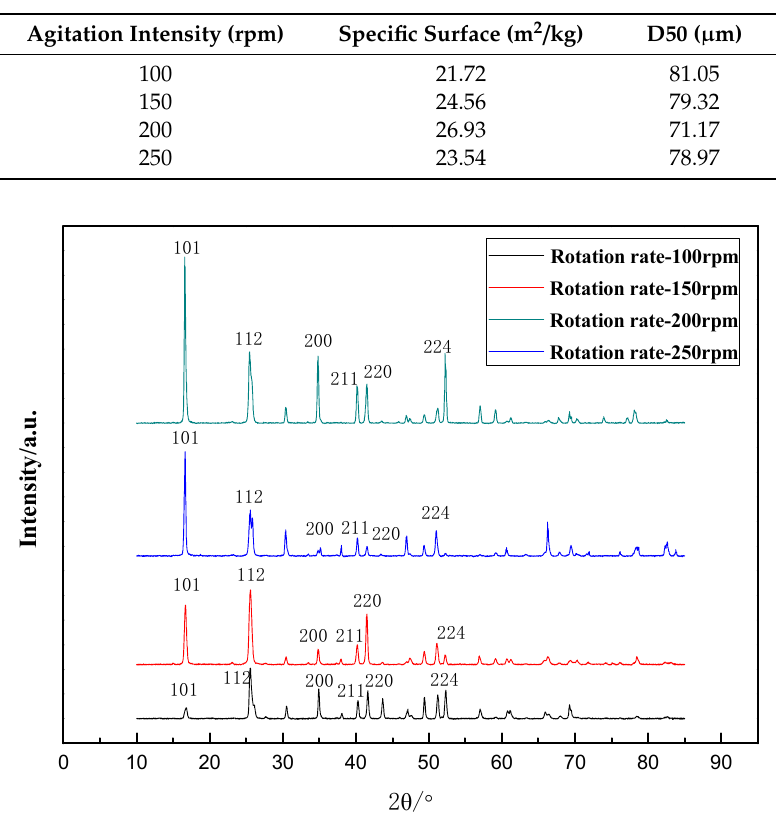
Figure 5. XRD patterns of the NH 4 ReO 4 recrystallization particles at different stirring speeds .